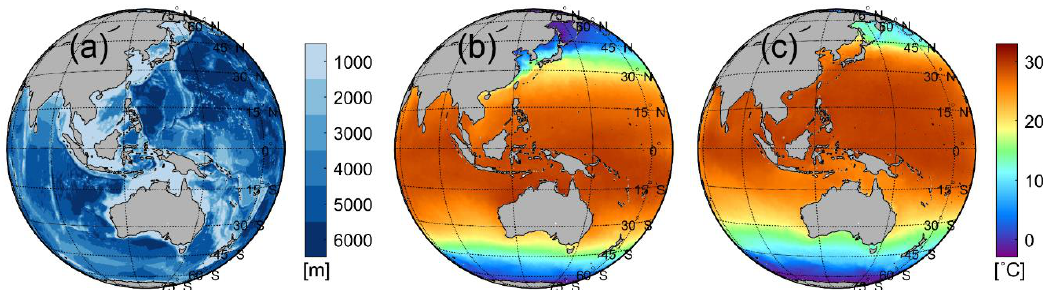
Figure 1. ( a ) Bathymetry and the sea surface temperature climatology in the COMS/MI full-disk area in ( b ) February and ( c ) August.